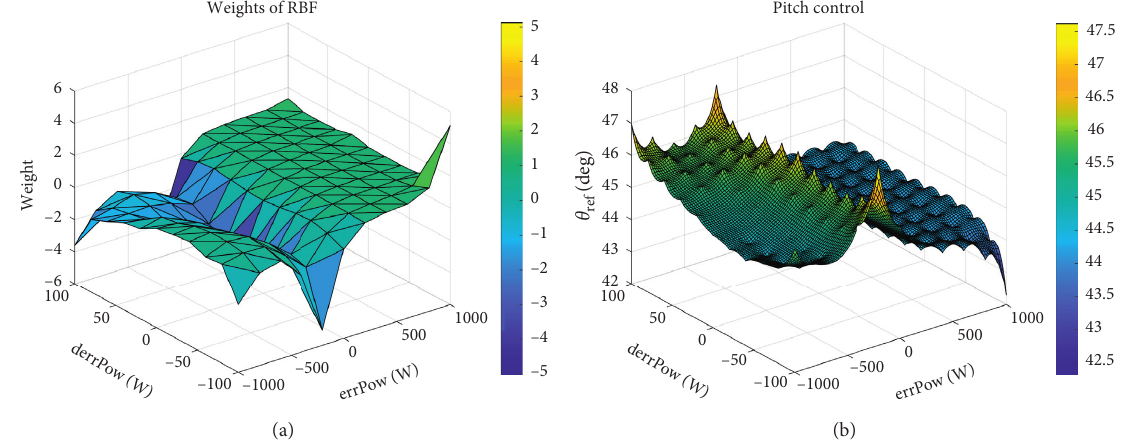
Figure 4: Weight surface (a) and pitch control law (b) after